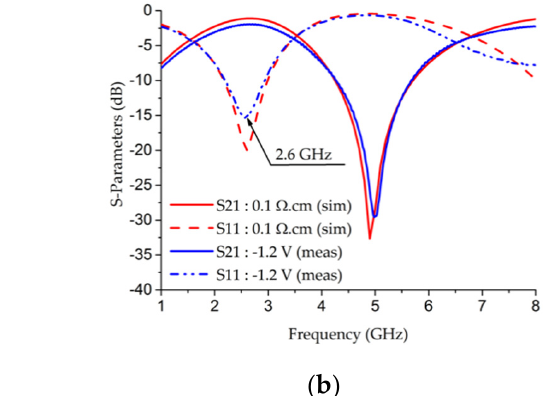
( b ) Figure 11. Comparison of simulated and measured results of switchable DBR 3 . ( a ) in the OFF state; ( b ) in the ON state. The last demonstrator, DBR 4 , has a wider and longer ScDDA than DBR 3 . This implies a capacitive effect in the OFF state, which explains why the resonant frequency, at 5.2 GHz, is lower than for the other demonstrators (Figure 12a). It also has a shorter resonator in the ON state, which gives a resonant frequency of 3.8 GHz in the ON state (higher than with DBR 3 ) (Figure 12b), with a bias voltage of − 1 V. The insertion losses are 1.94 dB and 1.95 dB in the OFF and ON states, respectively.